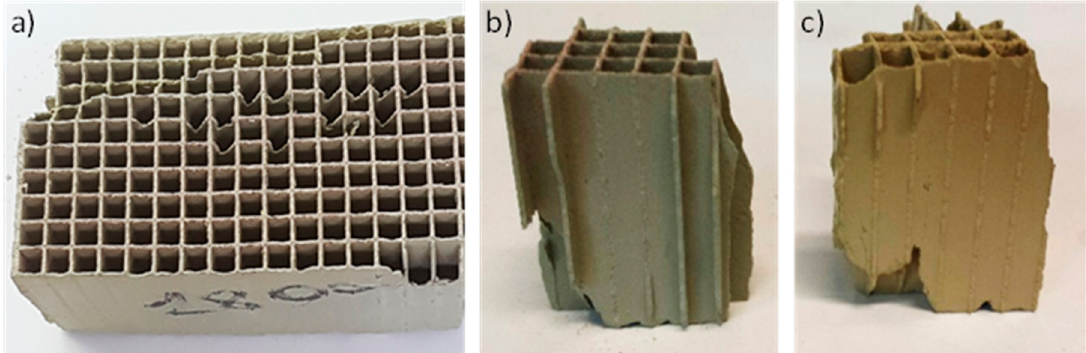
Figure 2. Appearance of the reaction-aged (18 kh) SCR honeycomb catalyst (( a , b ): samples taken from the inlet section of the monolith) in comparison with a sample of the same catalyst after regeneration by washing in water ( c ).